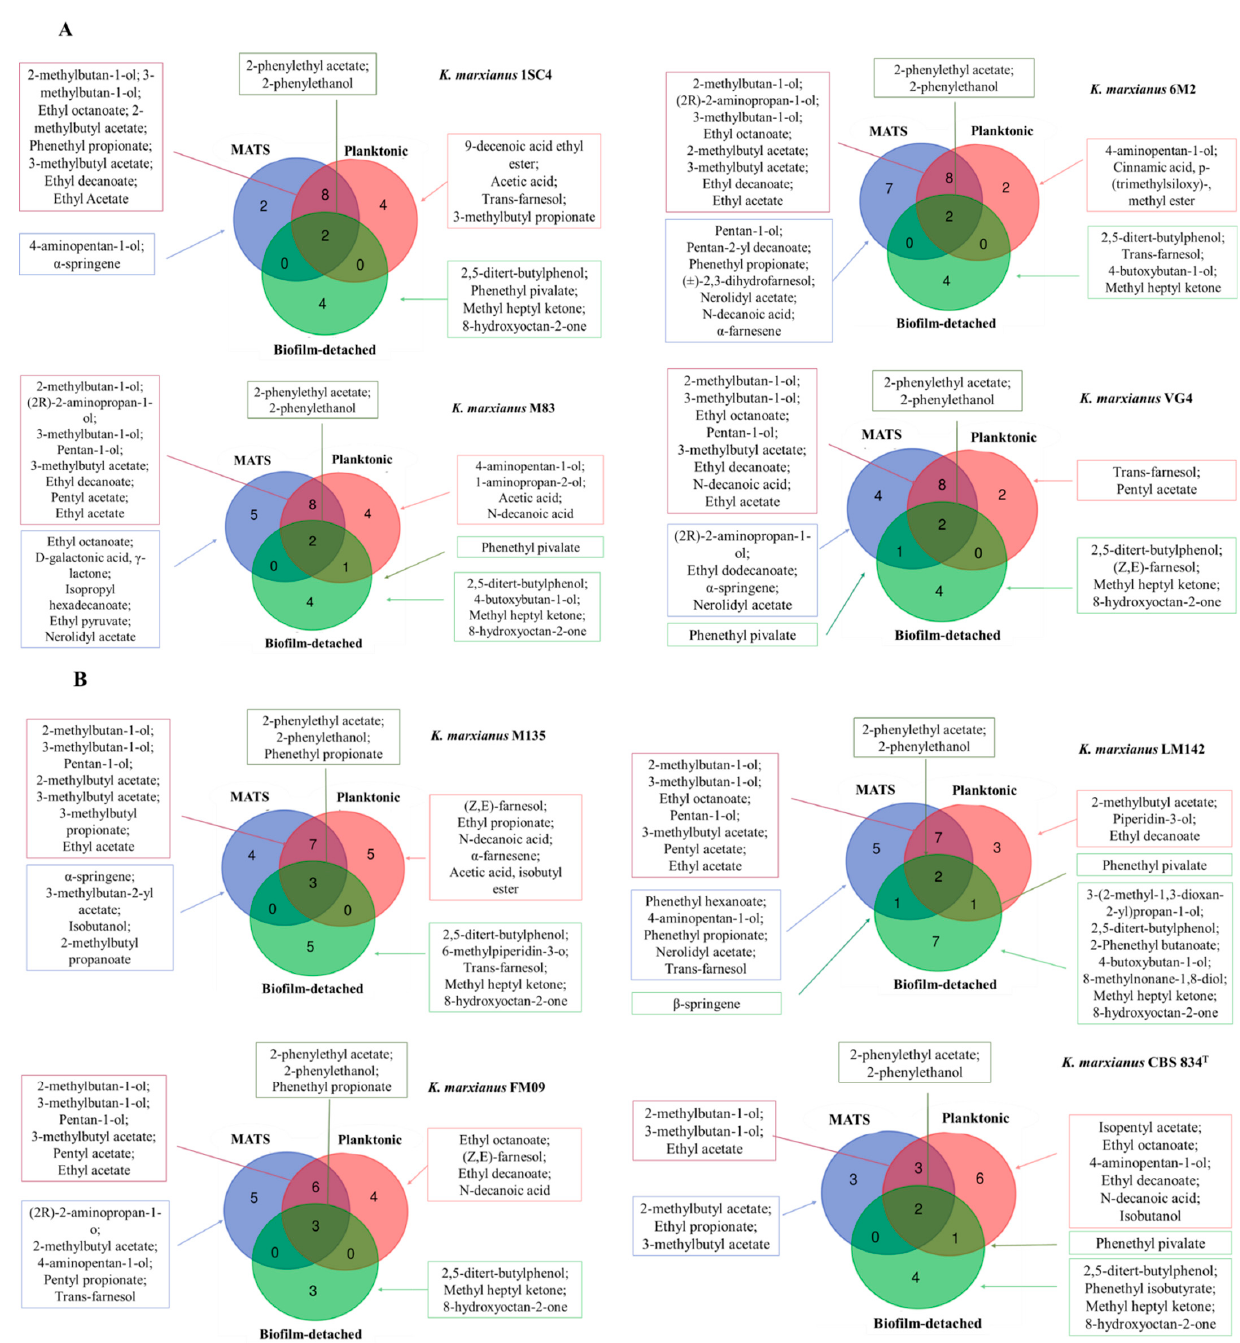
Figure 4. Similarities and differences of volatile compounds released by tested strains in different lifestyles shown by Venn diagram. Strains were divided into 2 groups on the basis of compounds shared by MATS forming-cells and planktonic cells. ( A ) MATS and planktonic cells sharing 8 compounds; ( B ) MATS and planktonic cells sharing less than 8 compounds .